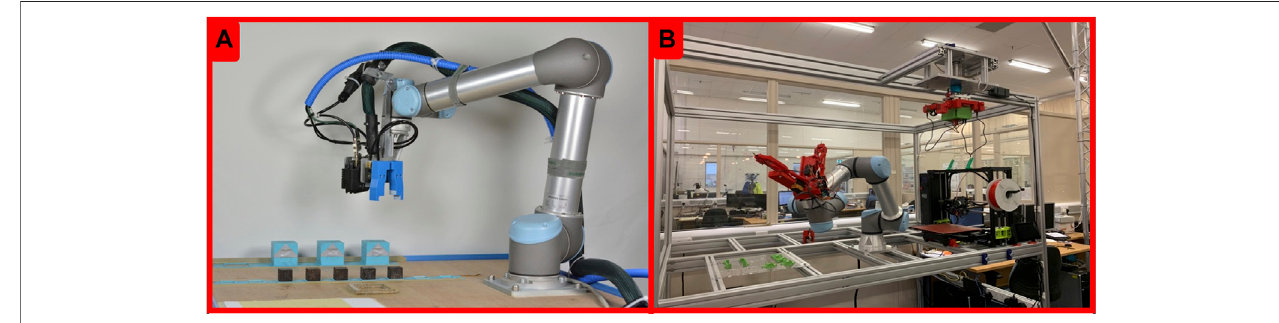
FIGURE2| Examplesofrobotreproductionfacilities.Photosoftwo(semi)automatedrobotreproductionfacilities. (A) :thesystemusedinCambridge(15). (B) :the one used in Bristol (18).